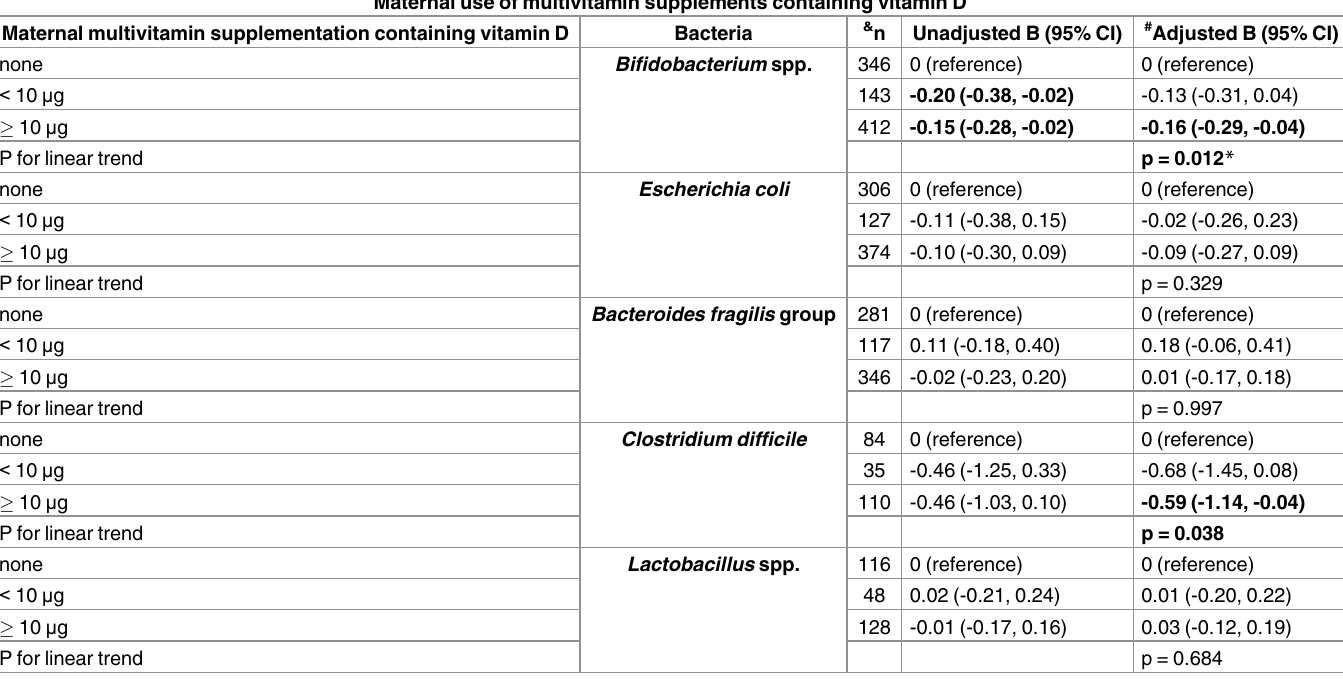
Table 3. Association between maternal use of multivitamin supplements containing vitamin D and log 10 colony forming units of bacterial species or groups in infants colonized with the respective bacteria. Maternal use of multivitamin supplements containing vitamin